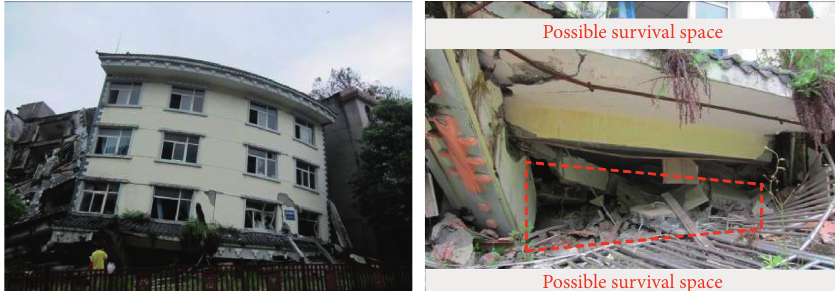
Figure 4: The final collapse state and possible survival space of the meteorological bureau building (the pictures from author Dai